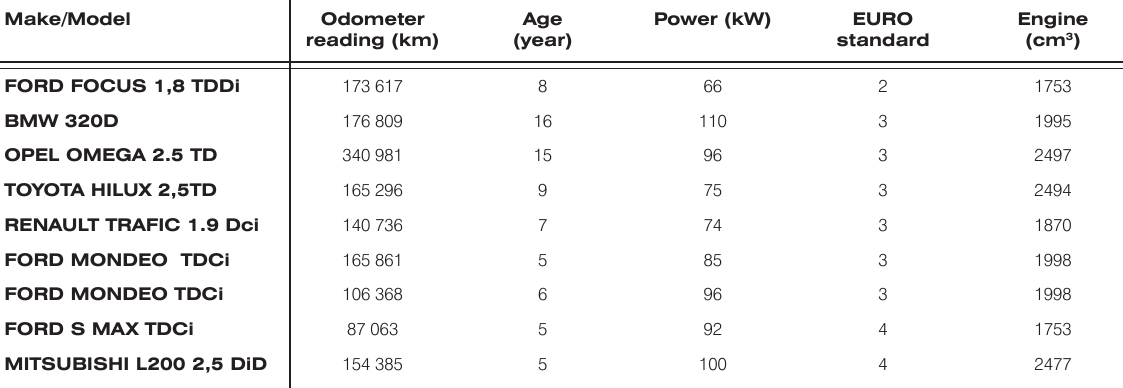
Table 1. Basic characteristics of light-duty vehicles